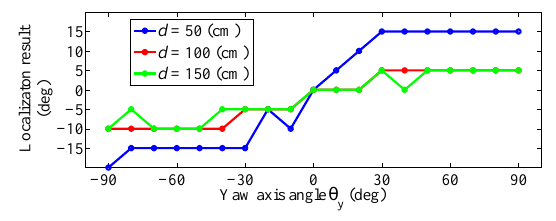
Figure 16. Observed power ratio in 800–1000 Hz band